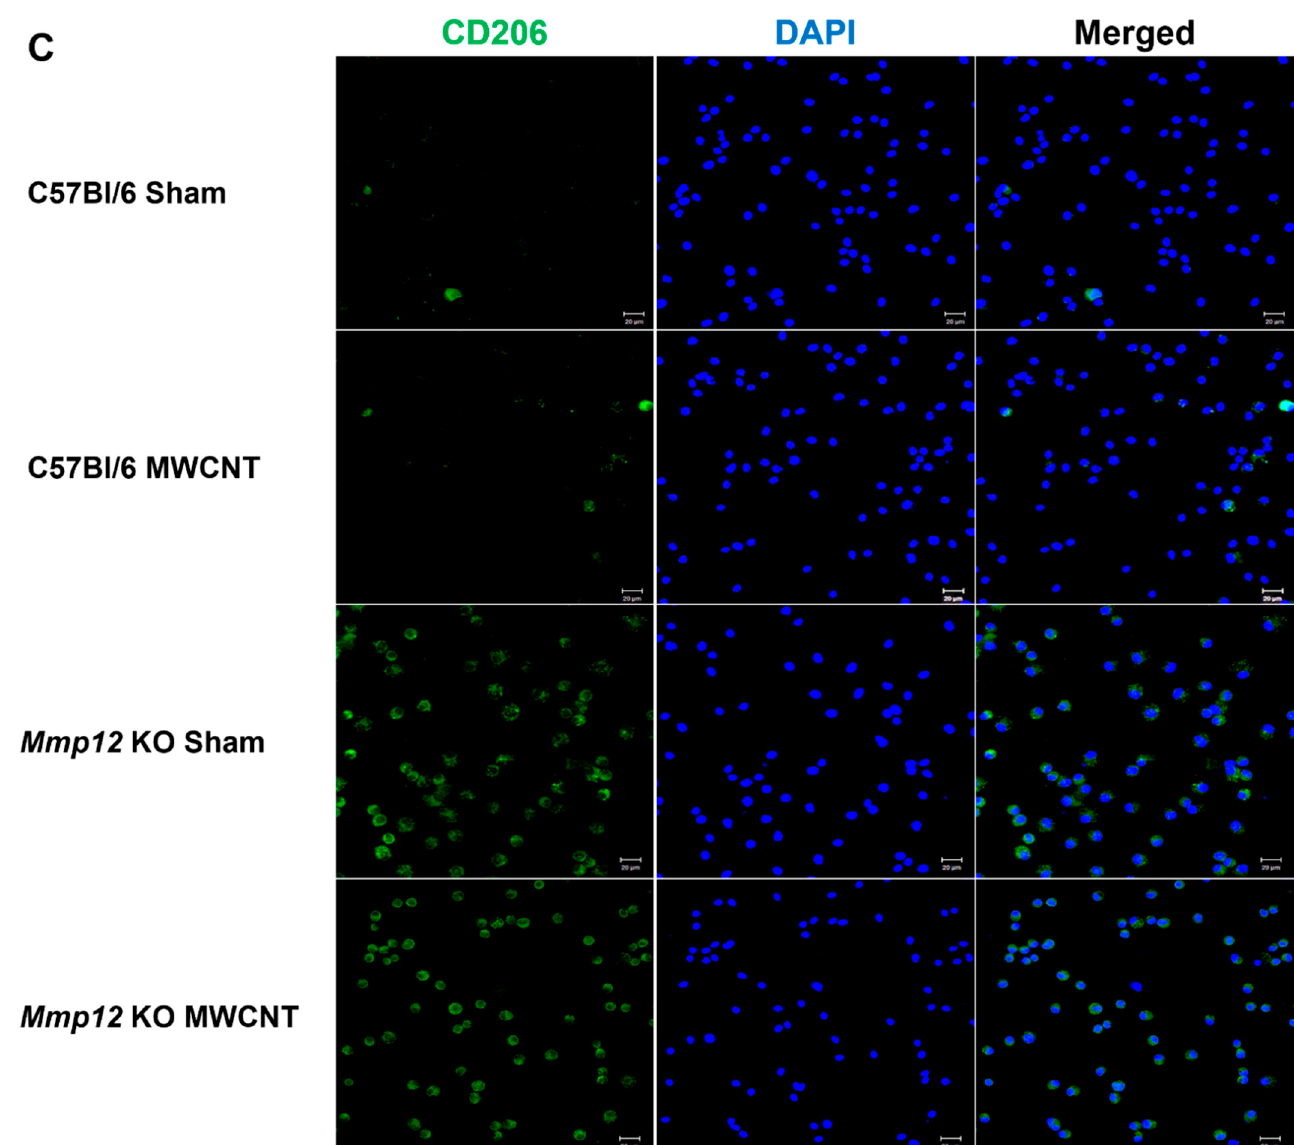
Figure 1. M2 is the predominant macrophage phenotype in Mmp12 KO mice. ( A ) Lung tissue from MWCNT-instilled C57Bl/6 and Mmp12 KO mice were stained with hematoxylin and eosin (H&E). ( B ) Immunofluorescent anti-CD206 staining of BAL cells showed an absence of CD206 protein in both the sham and MWCNT-instilled C57Bl/6 mice at 10 days. In Mmp12 KO at 10 days, CD206 was highly expressed. ( C ) At 60 days, few cells stained positive in C57Bl/6 sham- and MWCNT-instilled mice. In the Mmp12 KO strain, elevated expression of CD206 was observed in both MWCNT- and sham-instilled animals. Representative images of n ≥ 3 animals.